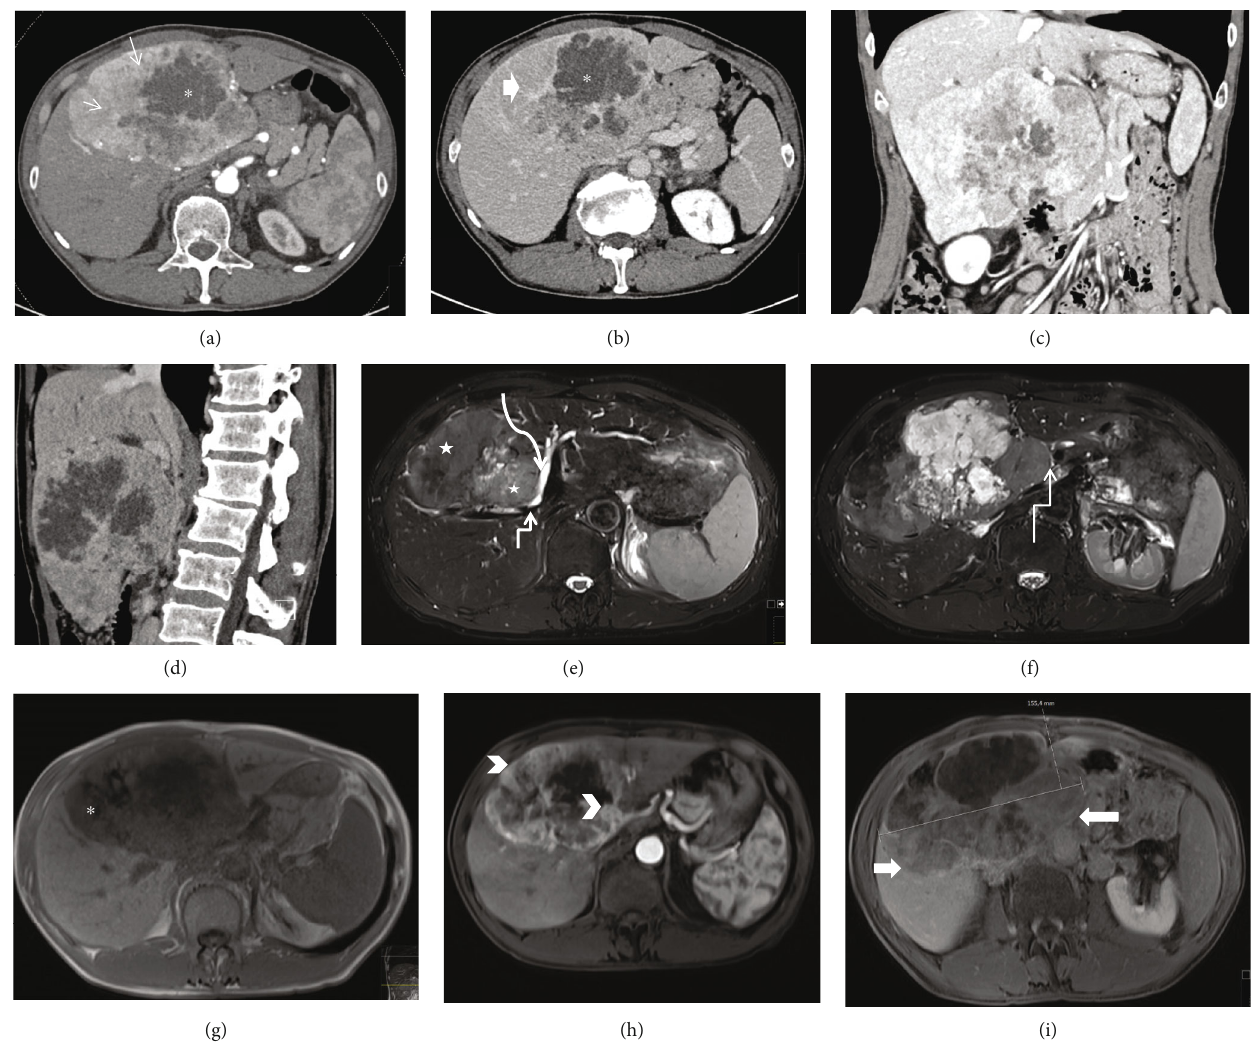
Figure 1: CT scan (a – d) showed a large multiloculated, partly nonvascularized ( ∗ ), partly hypervascularized (arrows) tumor with washout (thick arrow). MRI (e – i) con fi rmed a 15 : 5 × 9 : 6 × 14 : 2 cm tumor which was T1 hypointense ( ∗ ) and heterogeneously T2 hyperintense (stars) and displayed varying levels of peripheral enhancement on postcontrast sequences (arrow heads) with washout (thick arrows). The mass compressed the central and extrahepatic bile ducts (angulated arrows) with dilated intrahepatic bile ducts (curved